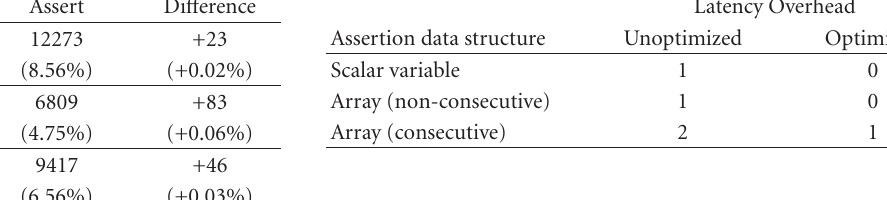
Table 4: Pipelined single-comparison